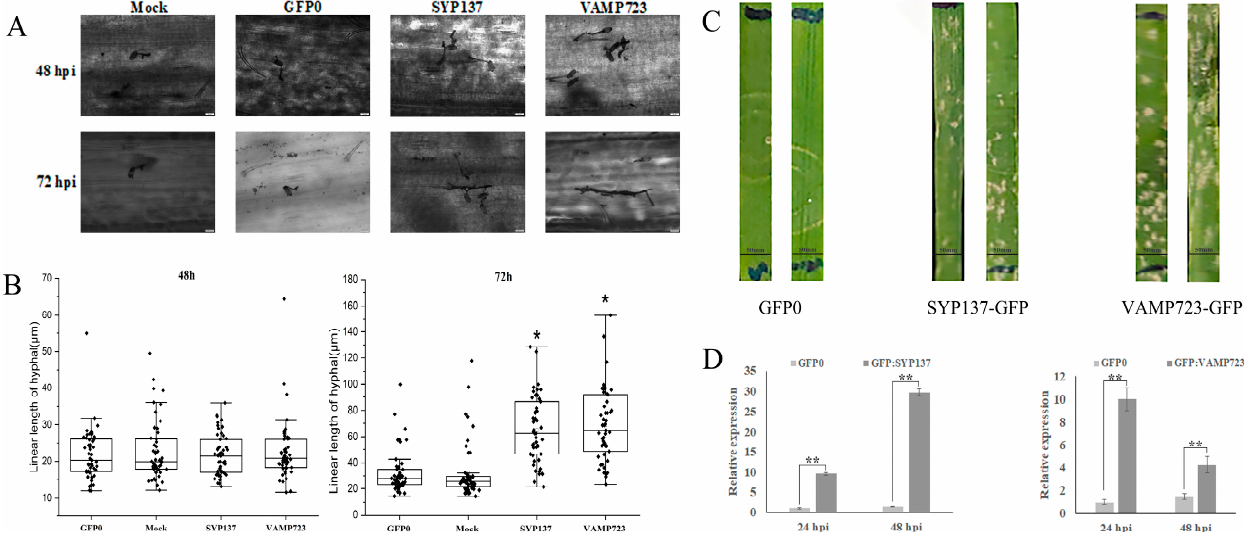
Figure 4. Effect of TaSYP137 and TaVAMP723 overexpression on the response of N9134R leaves to Bgt stress. ( A ): The hyphal histology pictures in the TaSYP137 and TaVAMP723 overexpressed N9134R leaves. ( B ): Bgt hyphal length after infection. ( C ): Images of infection symptoms 10 days after inoculation with Bgt . The reconstructed vectors, pYJ:TaSYP137:GFP and pYJ:TaVAMP723:GFP, and the pYJ::GFP control were applied to the leaves before inoculation with Bgt pathogen. The mock group was treated with buffer in the same way. ( D ): Relative expression levels of TaSYP137 and TaVAMP723 . Data were the mean of three biological replicates ± S.E. Asterisks denote significant differences by Student’s t -test analysis ( t -tests, * p < 0.05, ** p < 0.01). Int. J. Mol. Sci. 2023 , 24 , x FOR PEER REVIEW To further determine the function of TaSYP137/TaVAMP723 in wheat’s defense against powdery mildew infection, the barley stripe mosaic virus RNA-induced gene si- lencing system (BSMV-VIGS) was used to silence TaSYP137/TaVAMP723 . Phytoene de- saturase (PDS) silencing was used as a proof of concept, producing albino plants (Figure 5A). Silenced TaSYP137/TaVAMP723 plants and control plants were infected with Bgt, and the phenotypes were observed after 7 dpi. The results showed a significant decrease in the number and density of Bgt conidia in the silenced TaSYP137/TaVAMP723 plants (Fig- ure 5A). The qPCR assays demonstrated a silencing efficiency of 50-70%. (Figure 5B). These results suggest that the suppression of TaSYP137 / TaVAMP723 significantly en- hances wheat resistance to Bgt.